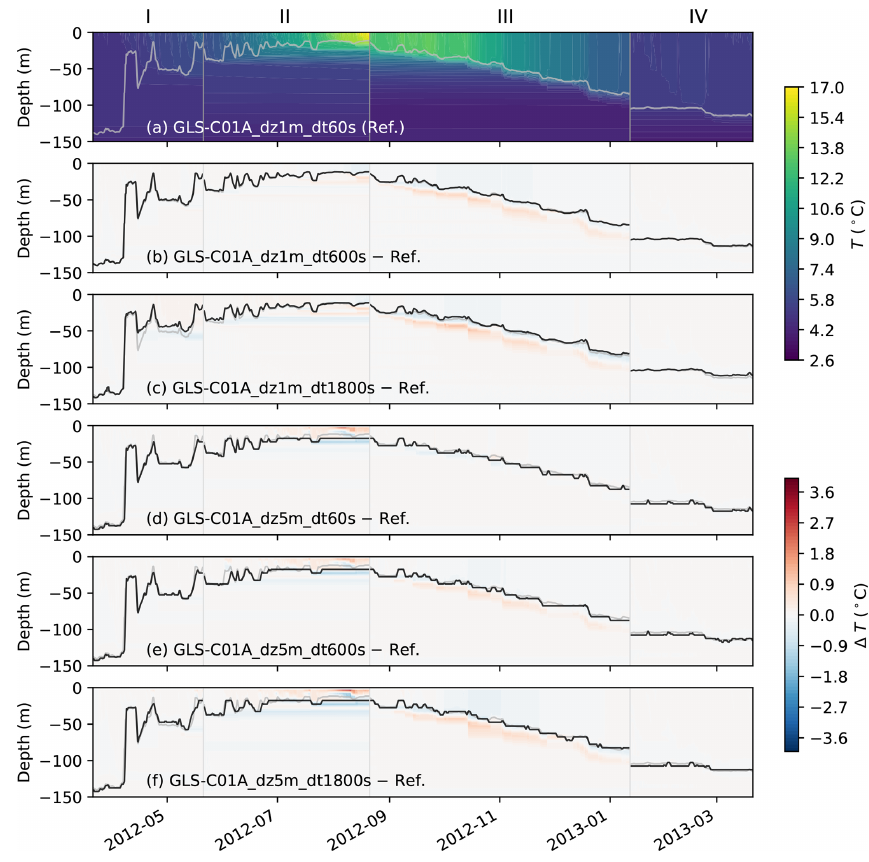
Figure 15. Same as Fig. 14 but for